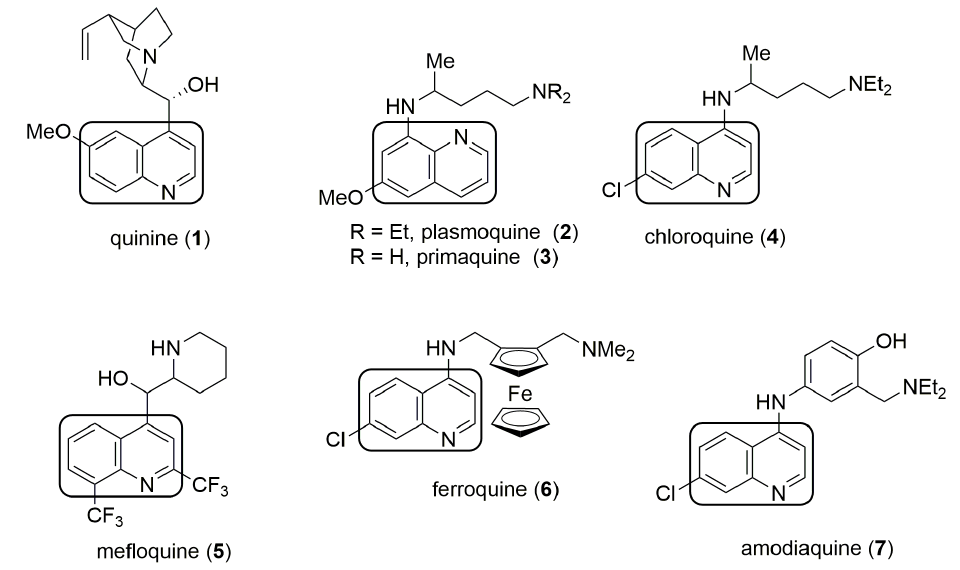
Figure 1 - Compounds containing quinoline heterocycle with antimalarial